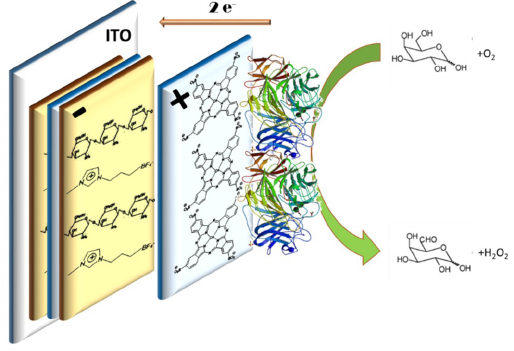
Figure 1. Structure of the [CHI+IL/CuPc S ] 2 -GAO biosensor. Scheme of the reaction.